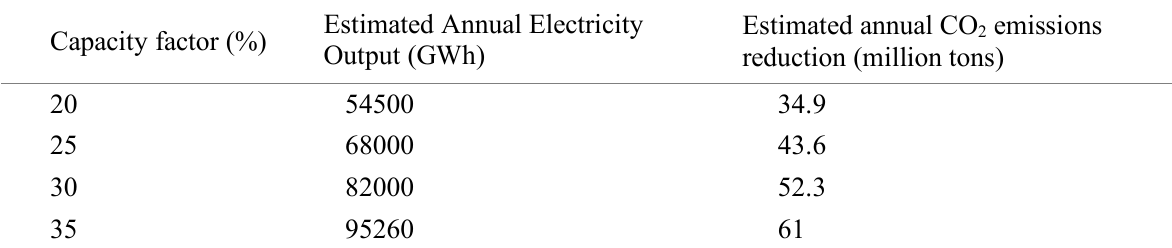
reduction from wind farms in 2002 2